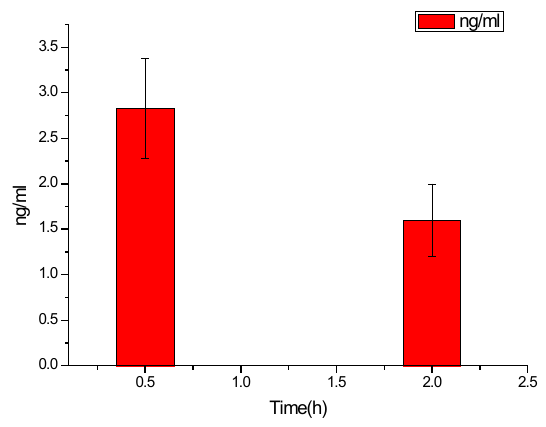
Figure 4 : The concentration of GB in the brain tissues